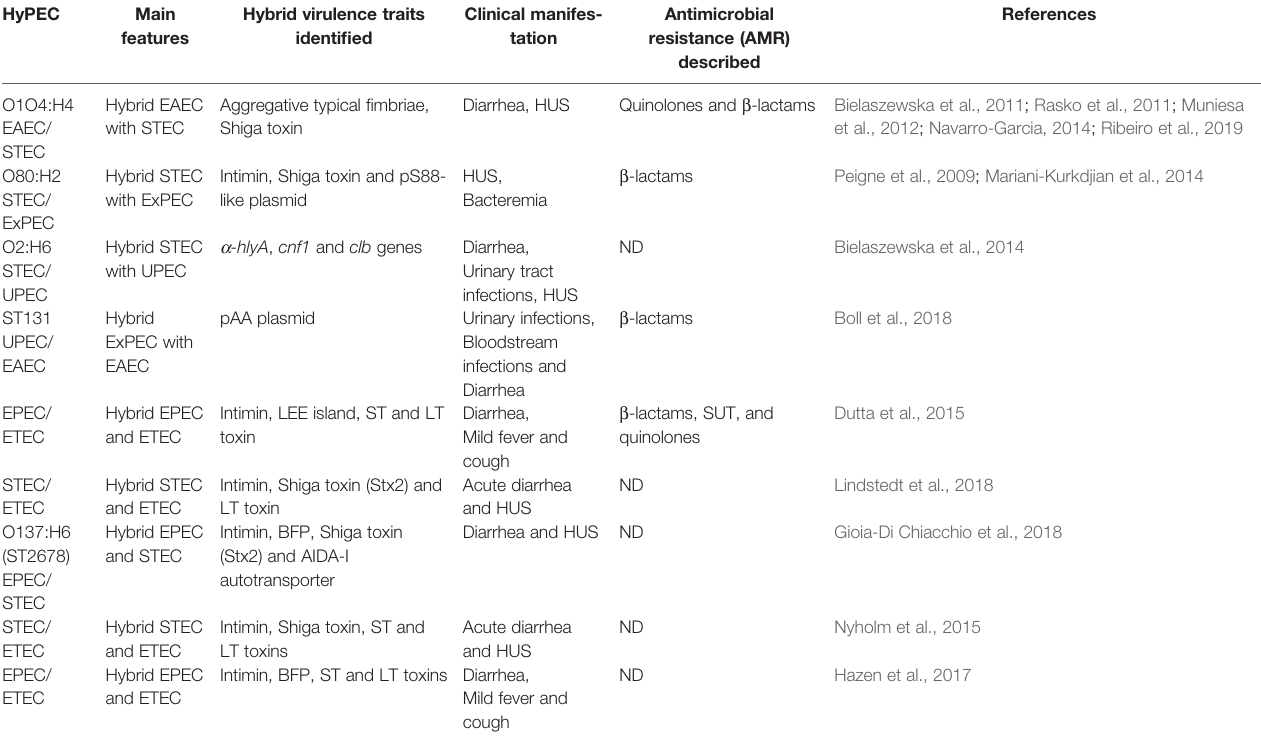
TABLE 2 | Hybrid pathogenic (HyPEC) main features